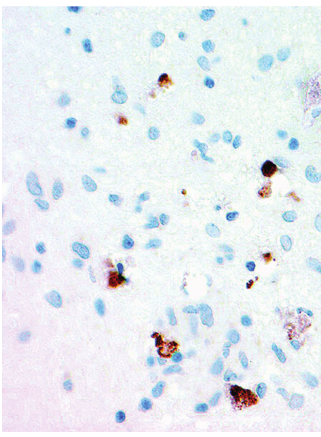
Figure 3: Immunohistochemistry for herpes simplex virus I/II is positive in scattered cells [HSV ×